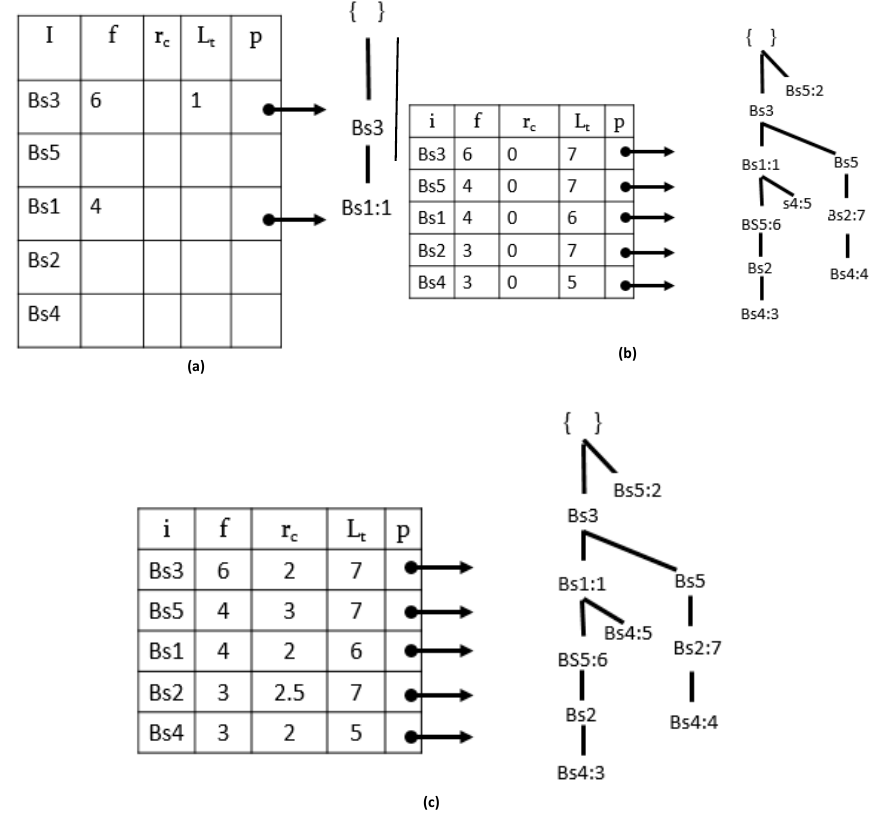
Figure 2. PPFP-tree construction with MinSup = 3, Maxpe r = 3, MPRD = 2. ( a ) PPFP-tree after inserting